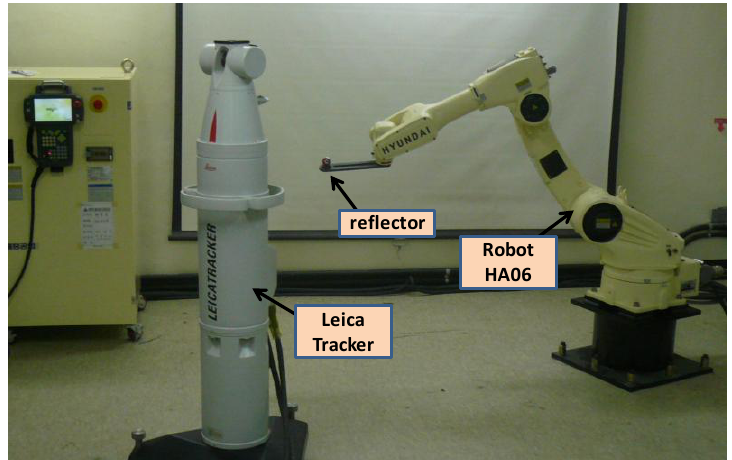
Figure 4. Experimental setup for